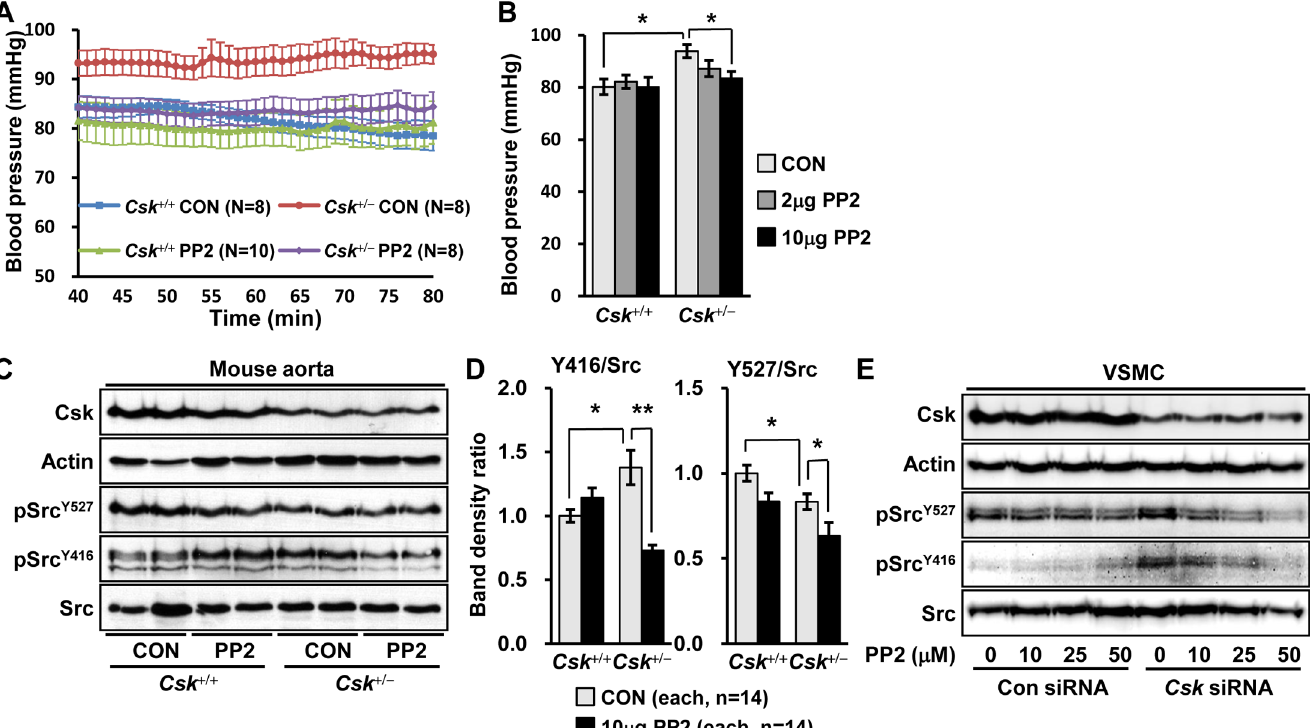
Fig 5. Decrease in blood pressure by PP2, a Src inhibitor in Csk +/- mice. (A) Csk +/- and Csk +/+ mice were i.p. injected with DMSO as control (CON) or PP2 (10 μ g per kg body weight), a Src inhibitor, and blood pressure was measured 24 hours after injections. Blood pressure is expressed as the average value at each minute from 40 min to 80 min after anesthesia. (B) Blood pressure was measured in Csk +/- and Csk +/+ mice treated with DMSO or PP2 (2, and 10 μ g per kg body weight) and the data is shown as the mean blood pressure for each group from 40 min to 80 min. (C) The representative blots of Csk and Src protein are shown following Western blotting in aorta of Csk +/- and Csk +/+ mice treated with DMSO or PP2 (10 μ g per kg body weight). (D) Protein levels are presented as the ratio of protein band densities in Csk +/- aorta to the wild-type. (E) Human VSMC cells were transfected by Csk siRNA and then treated with DMSO or PP2 (10, 25, and 50 μ M). Phosphorylated Src and Csk protein levels are shown following Western